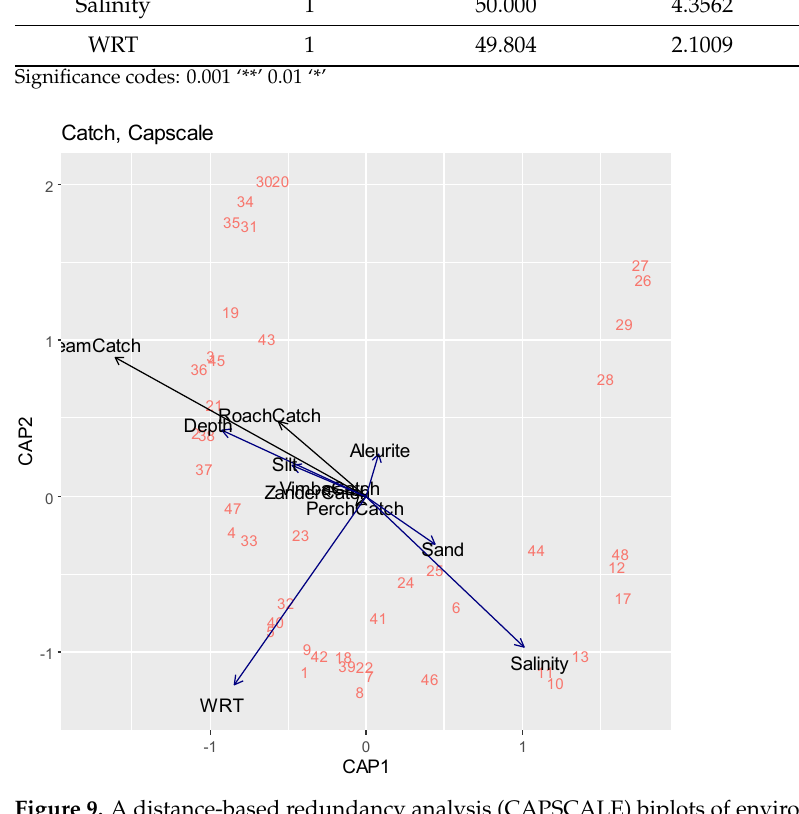
Figure 9. A distance-based redundancy analysis (CAPSCALE) biplots of environmental factors and catch of individual species interaction in each fishing square. The explanatory variables include sediment type, average depth, average salinity, and water residence time (WRT) in FS. Numbers represent ordinated fishing squares. Table 2. Statistically significant explanatory variables for the catch of individual species Table 1. Statistically significant explanatory variables for the CPUE (ordistep procedure ).